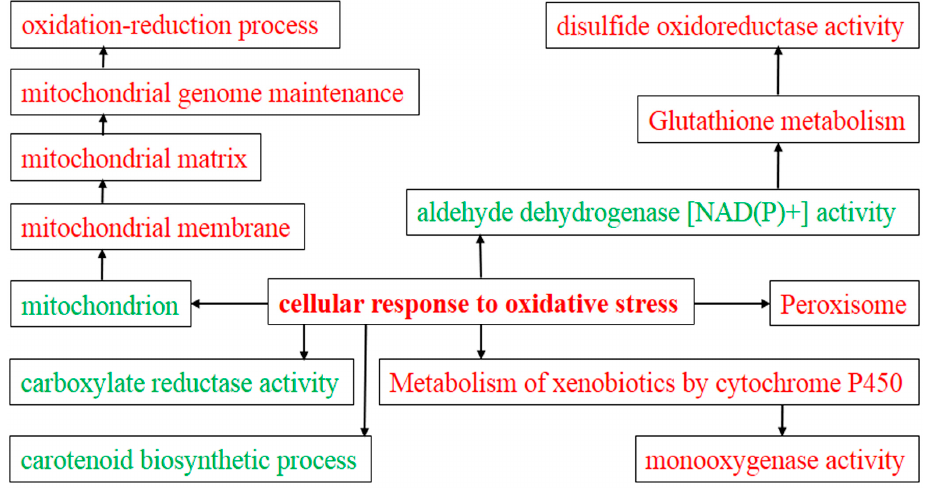
Figure 7. Analysis of enriched GO and KEGG terms involved in cellular redox regulation. Cellular components, molecular functions and biological process were included in the analysis. The terms that were up-regulated were colored in red and other down-regulated terms were colored in green.